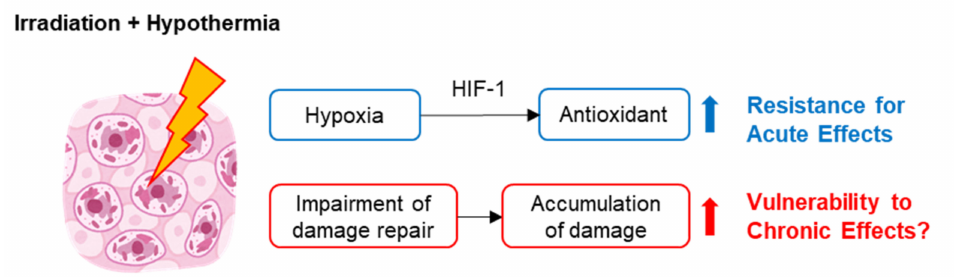
Figure 1. Overview of radiation-induced e ff ects in cells in hypothermic conditions. Hypothermia treatments protect organisms from the e ff ects of acute radiation via a hypoxic response. Additionally, it can induce the impairment of radiation damage repair